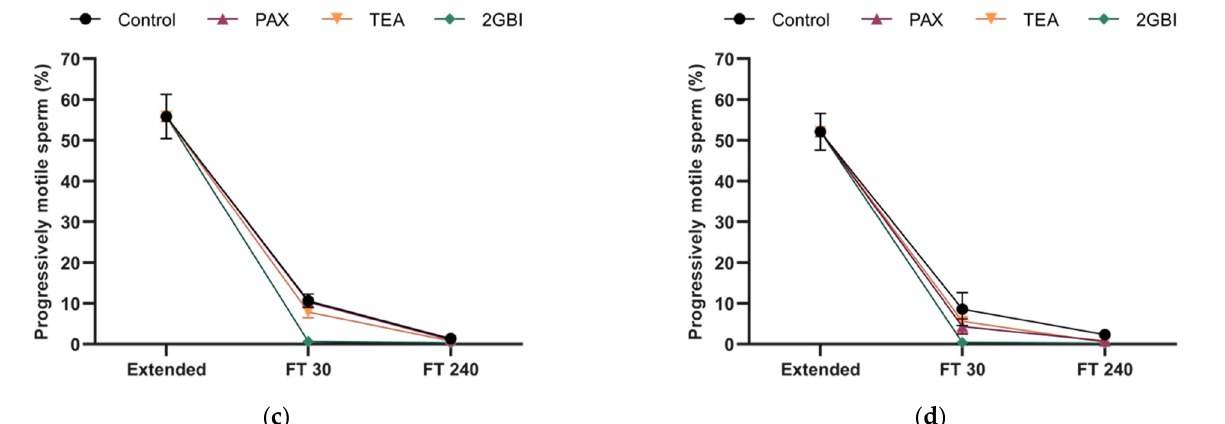
Figure 2. Percentages of total ( a,b ) and progressive ( c,d ) motile spermatozoa in extended and frozen–thawed (FT) samples at 30 min and 240 min post-thaw. In Experiment 1 ( n = 8), TEA, PAX, and 2-GBI blockers were added to LEY medium at 15 °C ( a,c ), whereas in Experiment 2 ( n = 9), they were added to LEYGO medium at 5 °C ( b,d ). Different superscripts indicate significant differences ( P < 0.05) between samples within the same time point. Results are given as mean ± SEM.